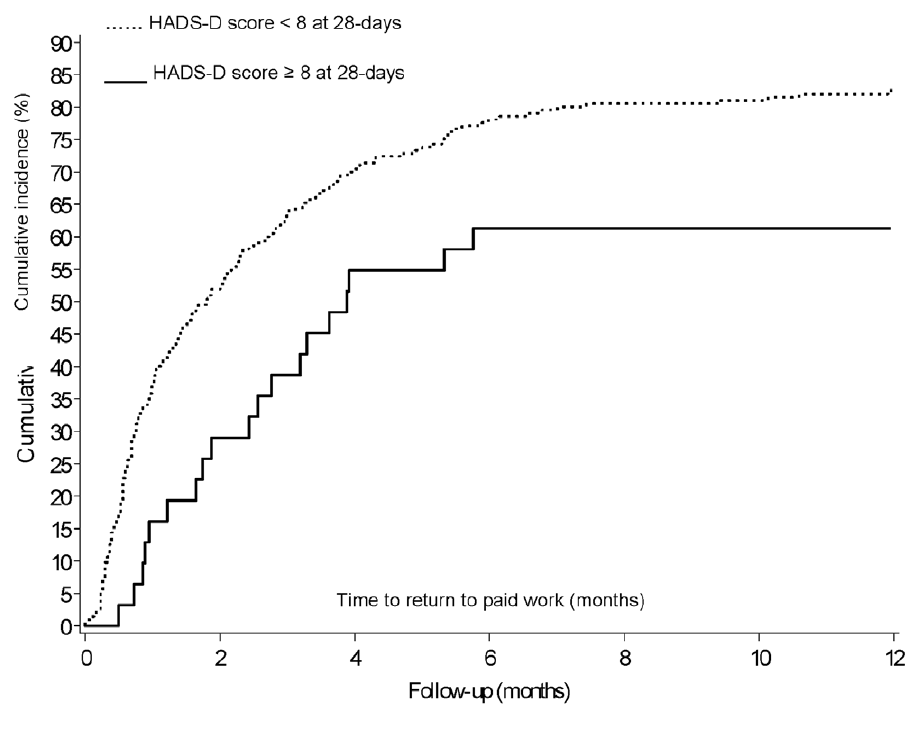
Figure 3. Cumulative incidence (Kaplan Meier plot) in time to return to work over one year by depression status at 28 days.